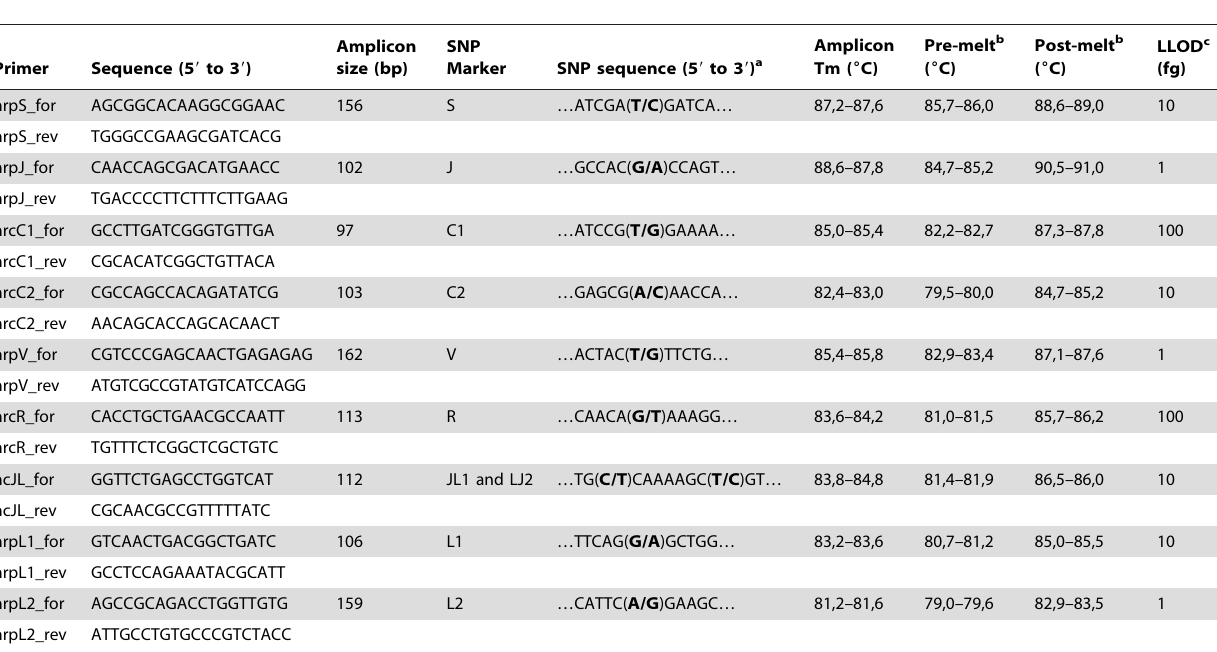
Table 2. Details and performances of the nine primer pairs used in this study for the identification and genotyping of P. savastanoi by